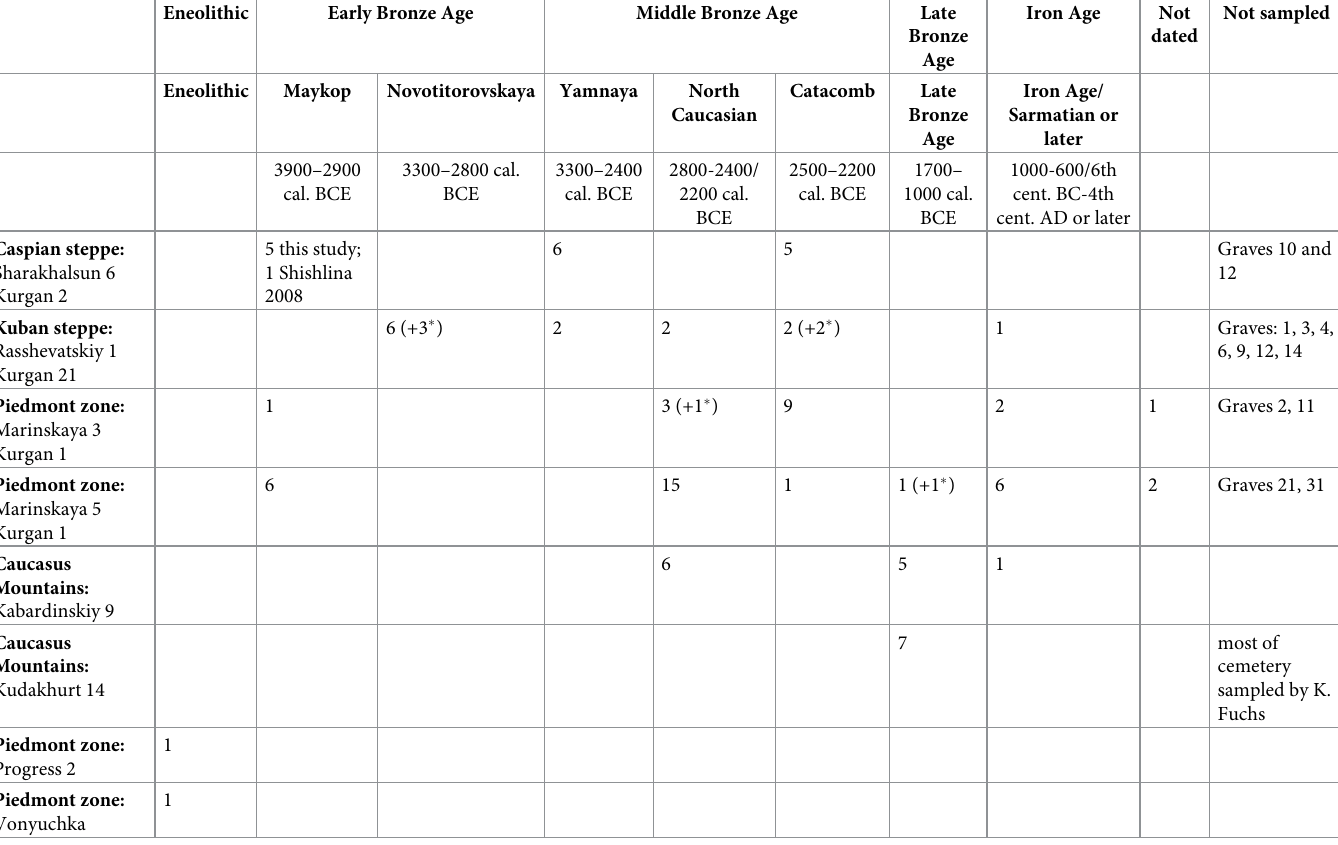
Table 1. Investigated sites and corresponding number of sampled human individuals grouped according to archaeological cultures and phases of the Bronze Age ( � collagen extraction or quality criteria